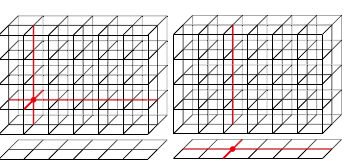
6 } . The crossing has coordinates ( z , y , x ) = ( 1.5, 6, 5.5 ) and sits in the center of the red square. (c) X stabilizer corresponding to the vertical-horizontal square indexed by ( i , β , γ ) = ( 1, 4, 2 ) ; its